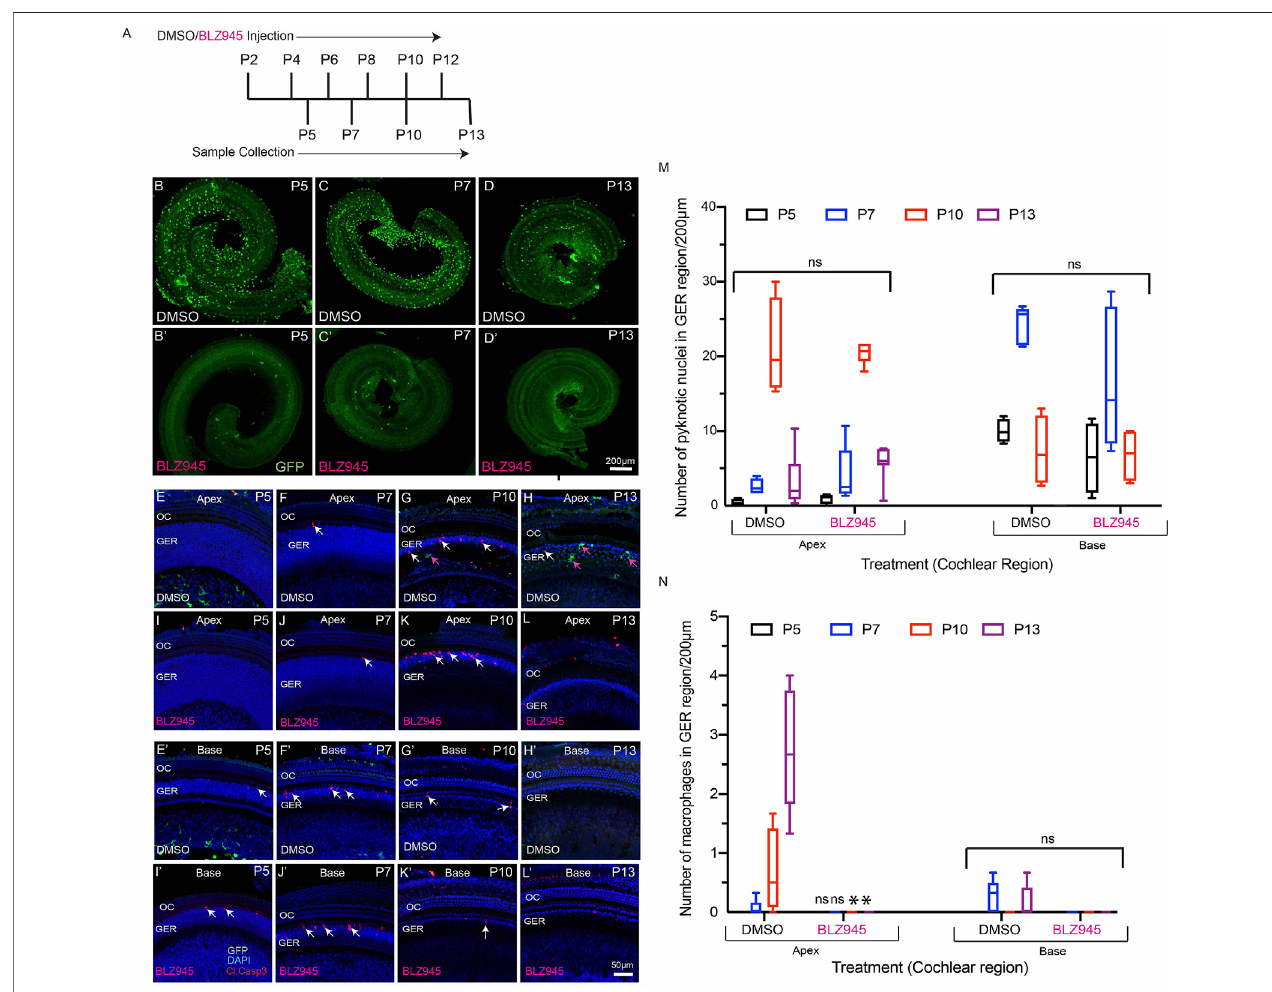
FIGURE 7 | BLZ945 treatment eliminates macrophages in the developing cochlea. (A) Treatment and sample collection timeline. (B – D 9 ) Cochlear whole mounts showing depletion of macrophages following treatment with the CSF1R antagonist BLZ945 (Green-GFP + macrophages). (E – L 9 ) Sensory epithelium of the developing cochlea showing apoptotic cells (red-cleaved caspase-3) and macrophages (green-GFP). Normal patterns of dying cells (white arrows) were observed in BLZ945- treatedcochleae. (M) NumberofmacrophagesintheGERregionofthedevelopingcochlea.NotethatBLZ945sharplyreducedthenumberofmacrophagesinthe GER. (N) Number of pyknotic nuclei in the GERregion ofthe developing cochlea. Images inB- (D 9 ) were taken using a × 5 objective lensand images in (E-L ’ ) weretaken using × 20objectivelens.Abbreviations:OC:OrganofCorti,GER:GreaterEpithelialRidge,P:PostnatalDay.(*p: p < 0.05,relativetocontrols(DMSO),ns:notsigni fi cant. (N (cid:2) 3 –